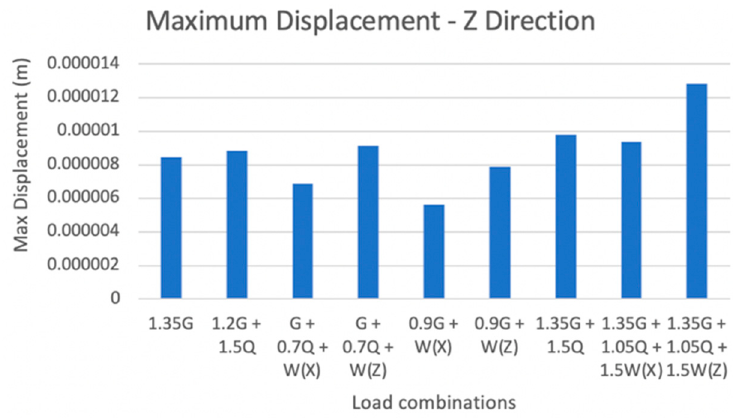
Figure 9. Maximum lateral displacement of DFF in the Z direction for each load combination.